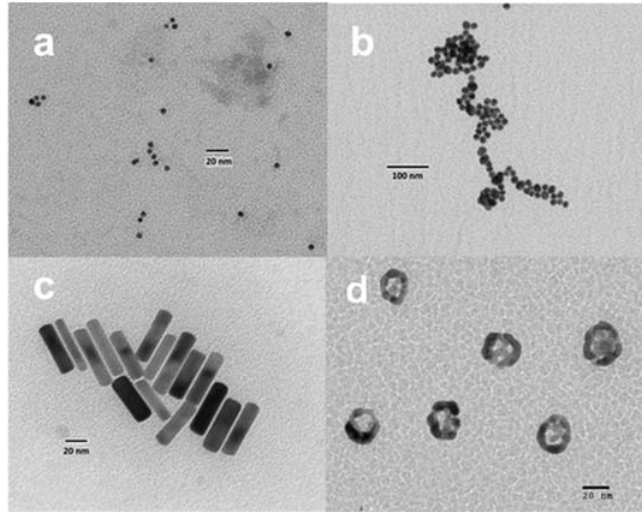
Figure 2. Negative stained transmission electron microscopy (TEM) micrographs of typical images of the diferent gold synthesized nanoparticles, ( a ) and ( b ) 5 nm and 18 nm of solid spherical gold nanoparticles (AuNPs), ( c ) gold nanorods (AuNRs), and ( d ) ultrasmall gold nanoshells (AuNSs).